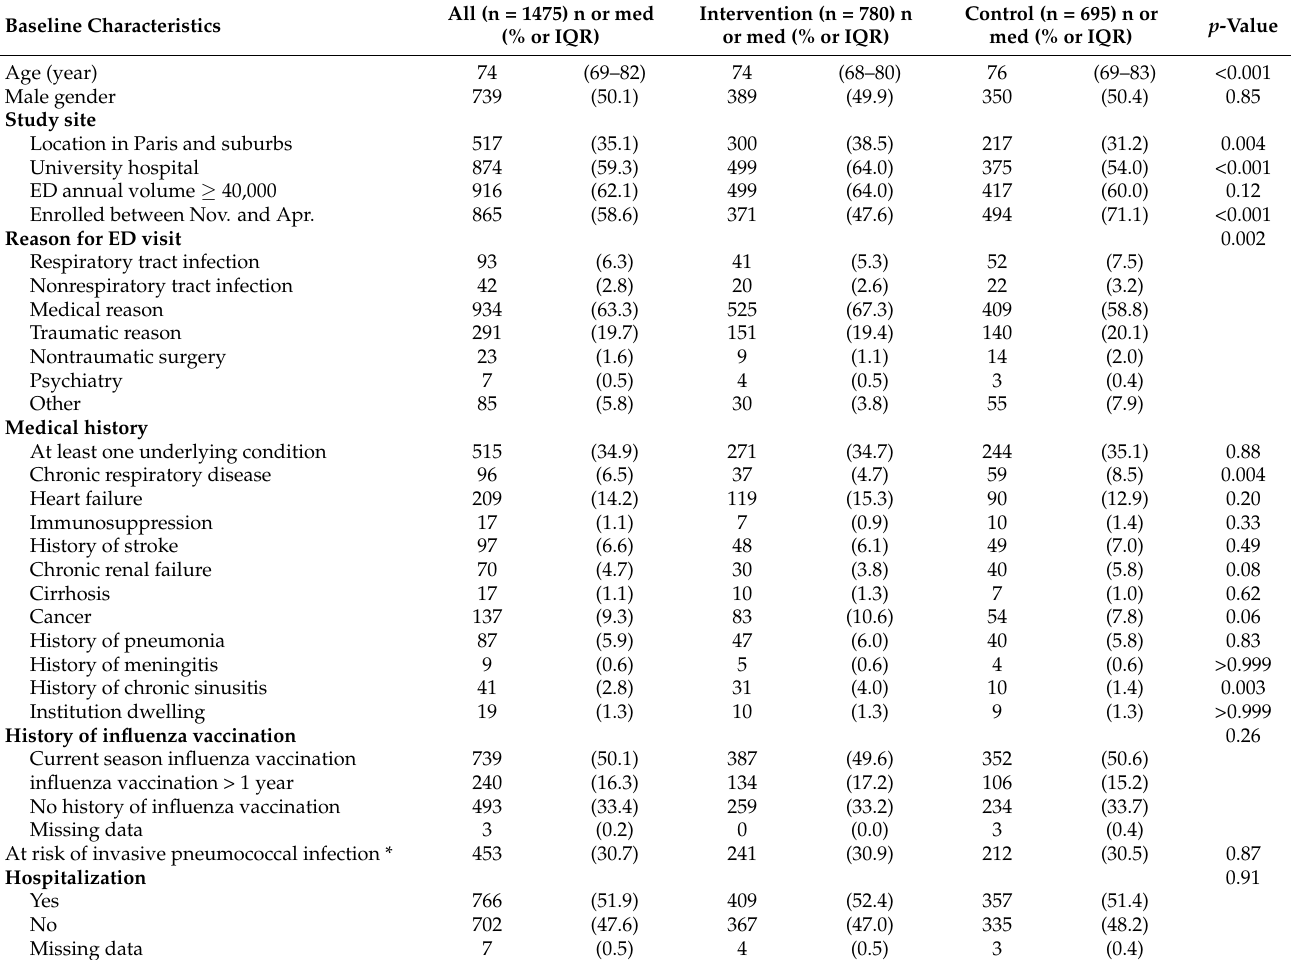
Table 1. Comparison of baseline patient characteristics between study arms; IMPROVED